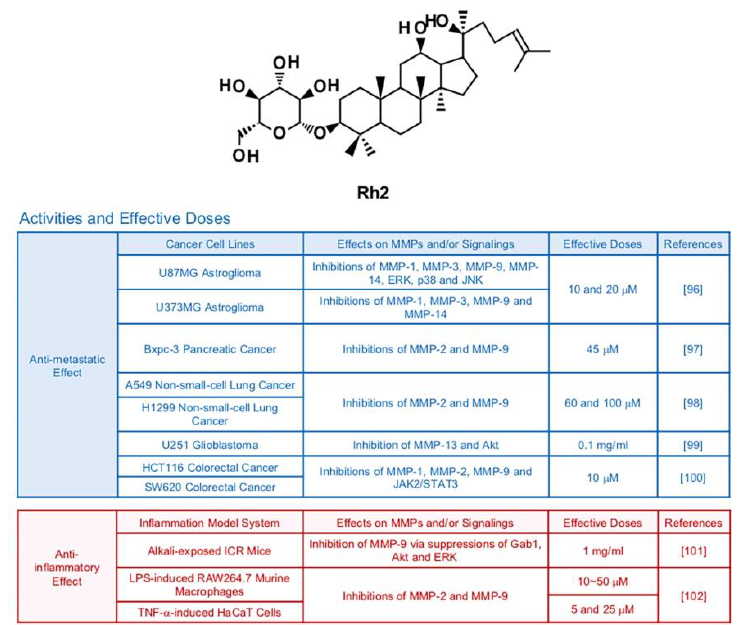
Figure 6. Summary of activities of ginsenoside Rh2. Structure of Rh2 and its effects on MMPs and/or signalings [96–102].